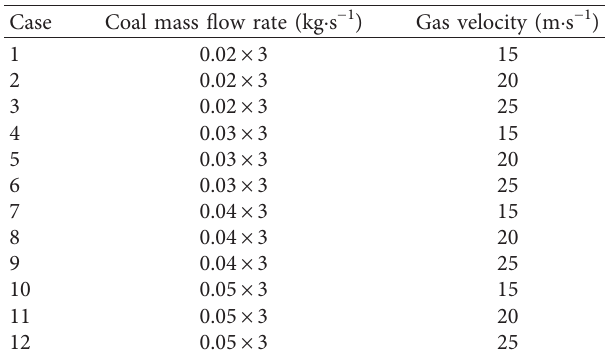
Table 2: Simulation cases setting.